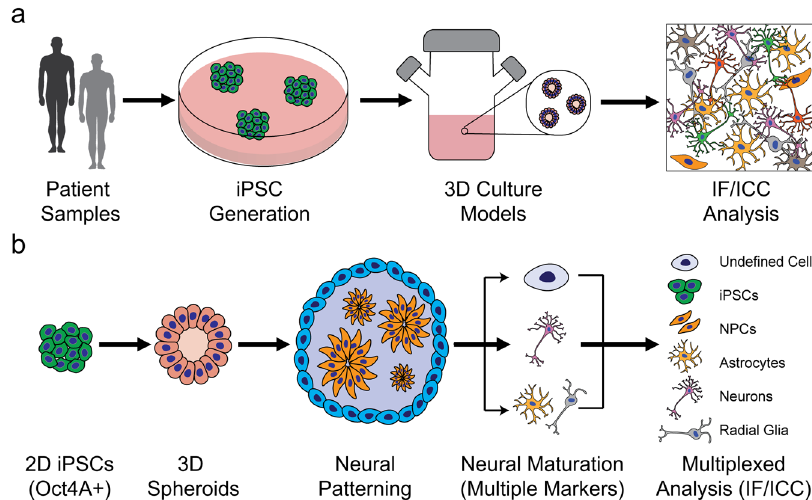
Fig. 1 Generating stem cell derived disease models and complex neuronal cultures based on patient iPSCs requires careful and extensive validation. a Process fl ow to generate disease-speci fi c stem cell lines from patients to model in vitro complex neurodevelopmental and neurodegenerative diseases using 3D spheroid cultures of cortical and motor neurons. b Stem cell-derived 3D spheroid neural cultures were dissociated and used to generate high- content data for culture and disease modeling. Cells are subsequently analyzed to generate speci fi c culture breakdowns using PRISM for in-depth characterization of neural cultures via multiplexed